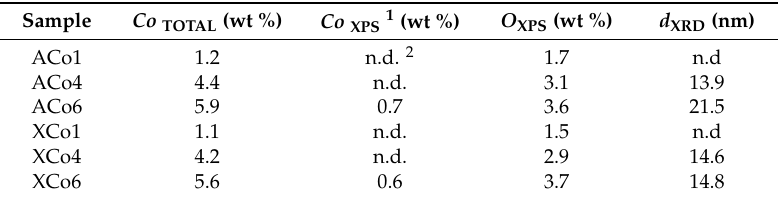
Table 2. Chemical characteristics of the carbon gels.